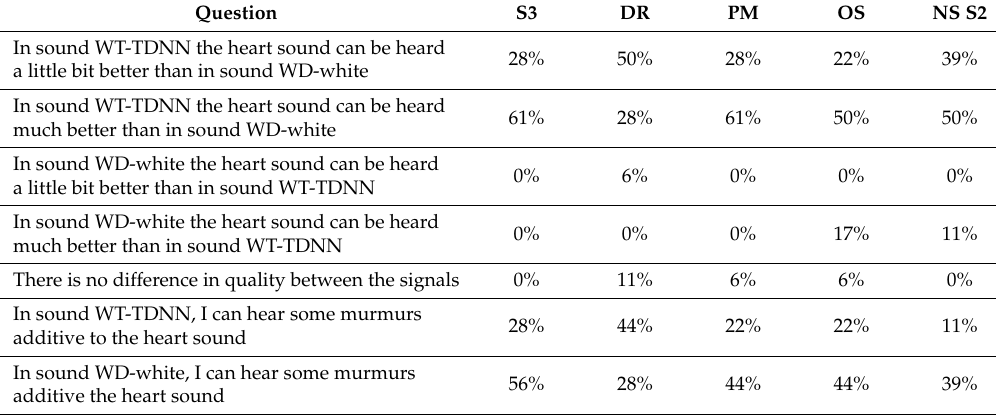
Table A2. Comparison of WT-TDNN with WD-white.